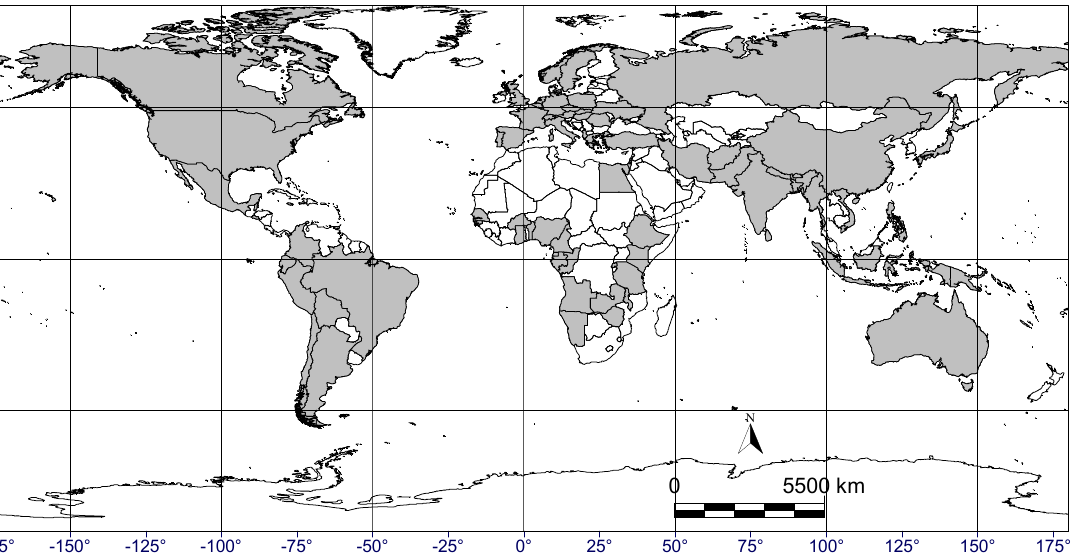
Figure 6. The top ten journals, totaling 164 papers, with most publications analyzed in this review. Source: own elaboration.